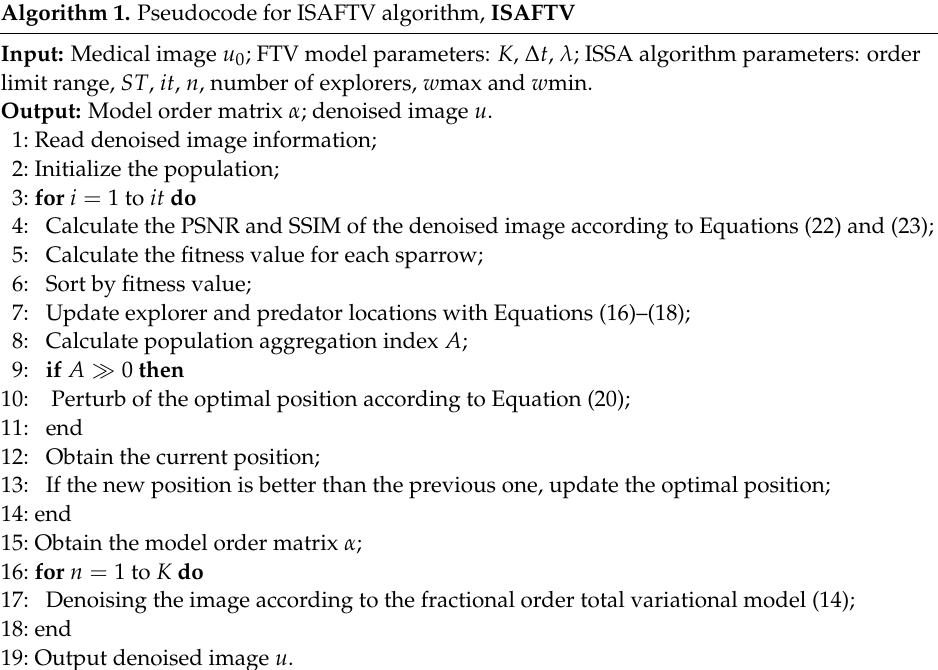
Algorithm 1. Pseudocode for ISAFTV algorithm,